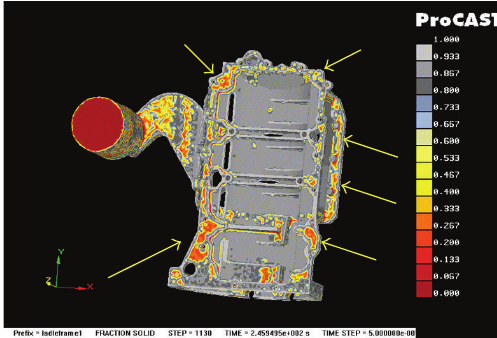
Figure 11: Hot spots at the end of solidification step, which are susceptible to casting